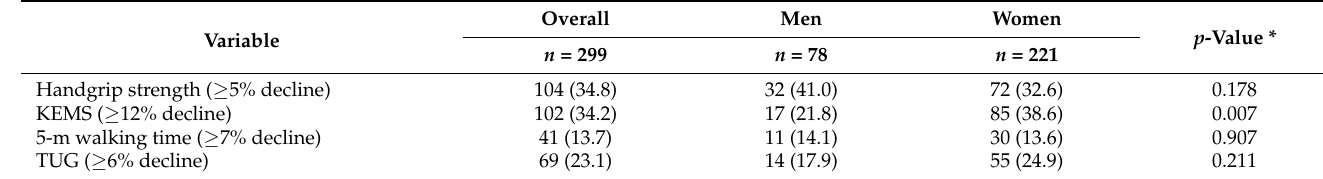
Table 2. Changes in physical function during one year of follow-up.